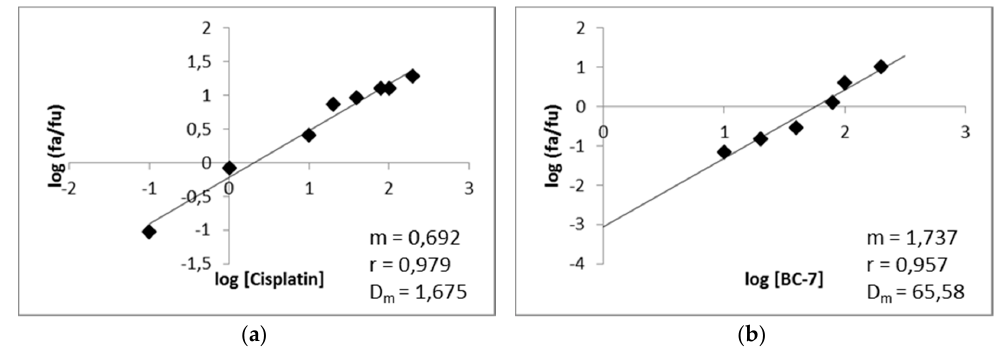
Figure 7. Median-e ff ect plots of ( a ) cisplatin and ( b ) BC-7 for HeLa cells. After 48 h of exposure,